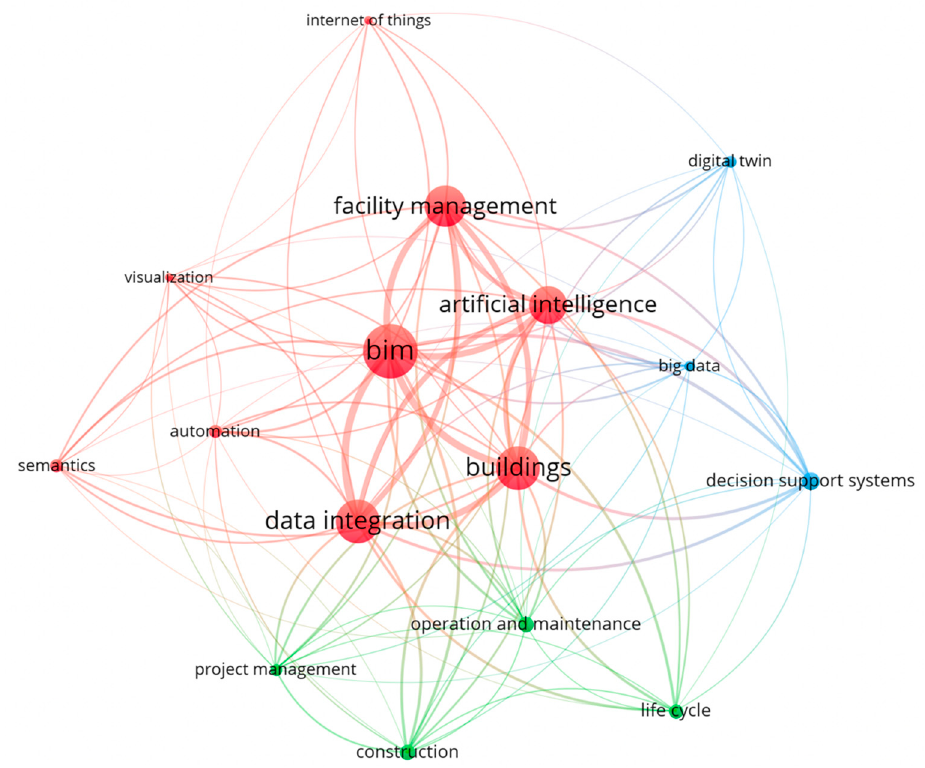
Figure 4. Keyword clustering by color (red, blue, and